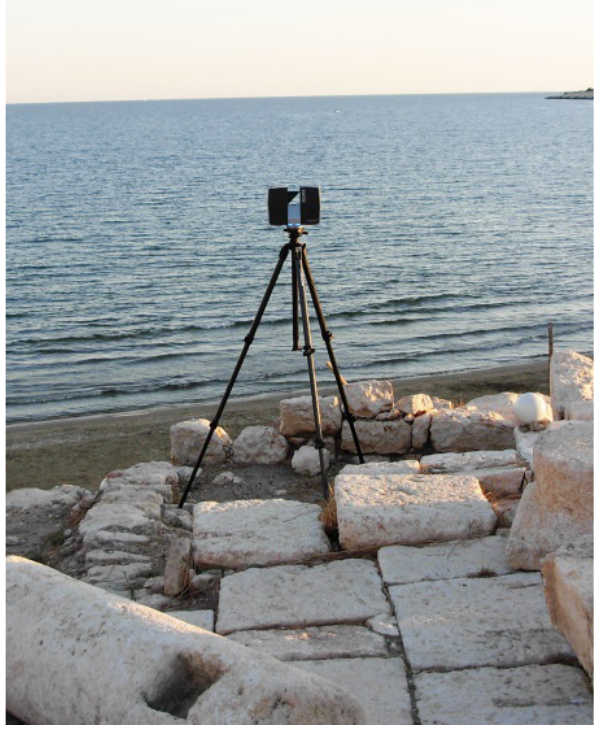
Figure 6. Faro Focus 3D.